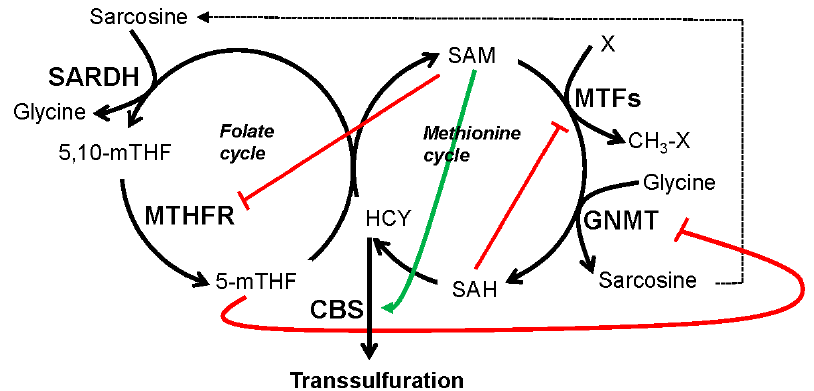
Figure 2. Regulation of the one-carbon metabolism maintains a balanced flux between the folate and methionine cycles and associated pathways. Metabolites produced within the folate and methionine pathways regulate the activity of the enzymes within the one-carbon metabolism network to maintain the balance of methyl groups and metabolites within the folate and methionine cycles and associated pathways and to allow for changes in response to cellular demands or growth conditions. See text for details. Enzymes are in bold, and substrates/cofactors are depicted in regular font. Black arrows indicate the directionality of reactions, red lines indicate inhibition, and the green arrow indicates activation. Enzyme abbreviations are as follows: SARDH: Sarcosine dehydrogenase; MTHFR: Methylene tetrahydrofolate reductase; CBS: Cystathionine beta-synthase; MTFs: Methyltransferases; GNMT: Glycine- N -methyltransferase.